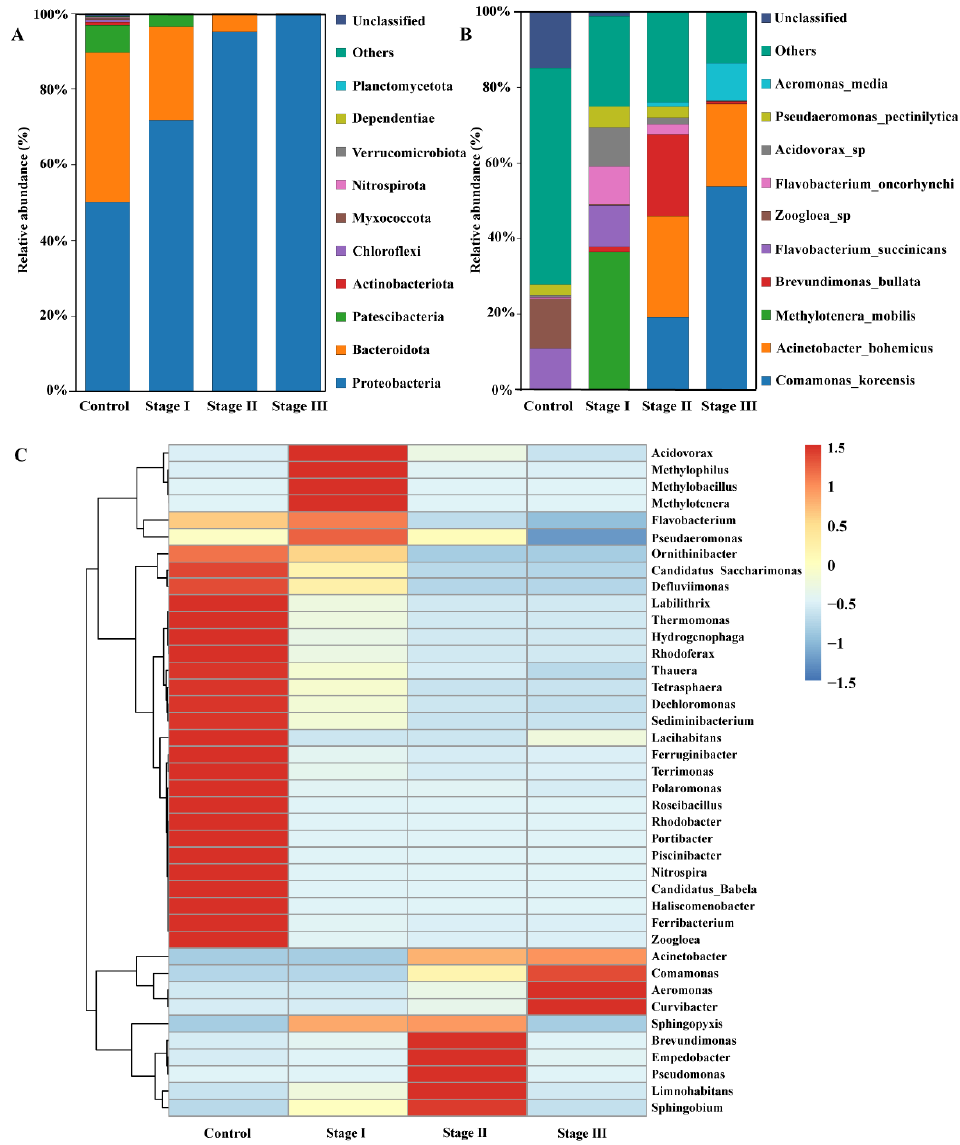
Figure 5. The effect of bisphenol A (BPA) on the microbial populations of sequencing batch reactor (SBR) activated sludge. ( A ) Phylum-level abundance; ( B ) Species-level abundance; ( C ) Genus-level heat map. (The color gradient from blue to red indicates a relative abundance from low to high).